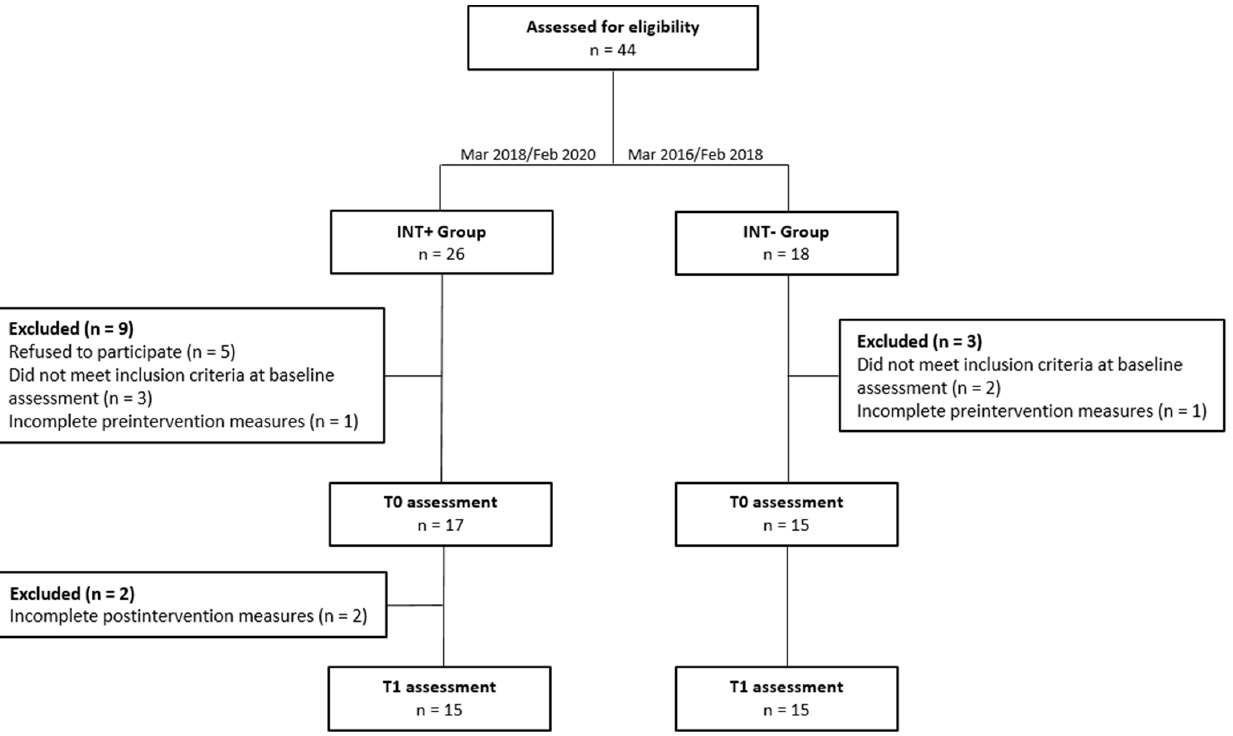
Figure 1. Participant flowchart.